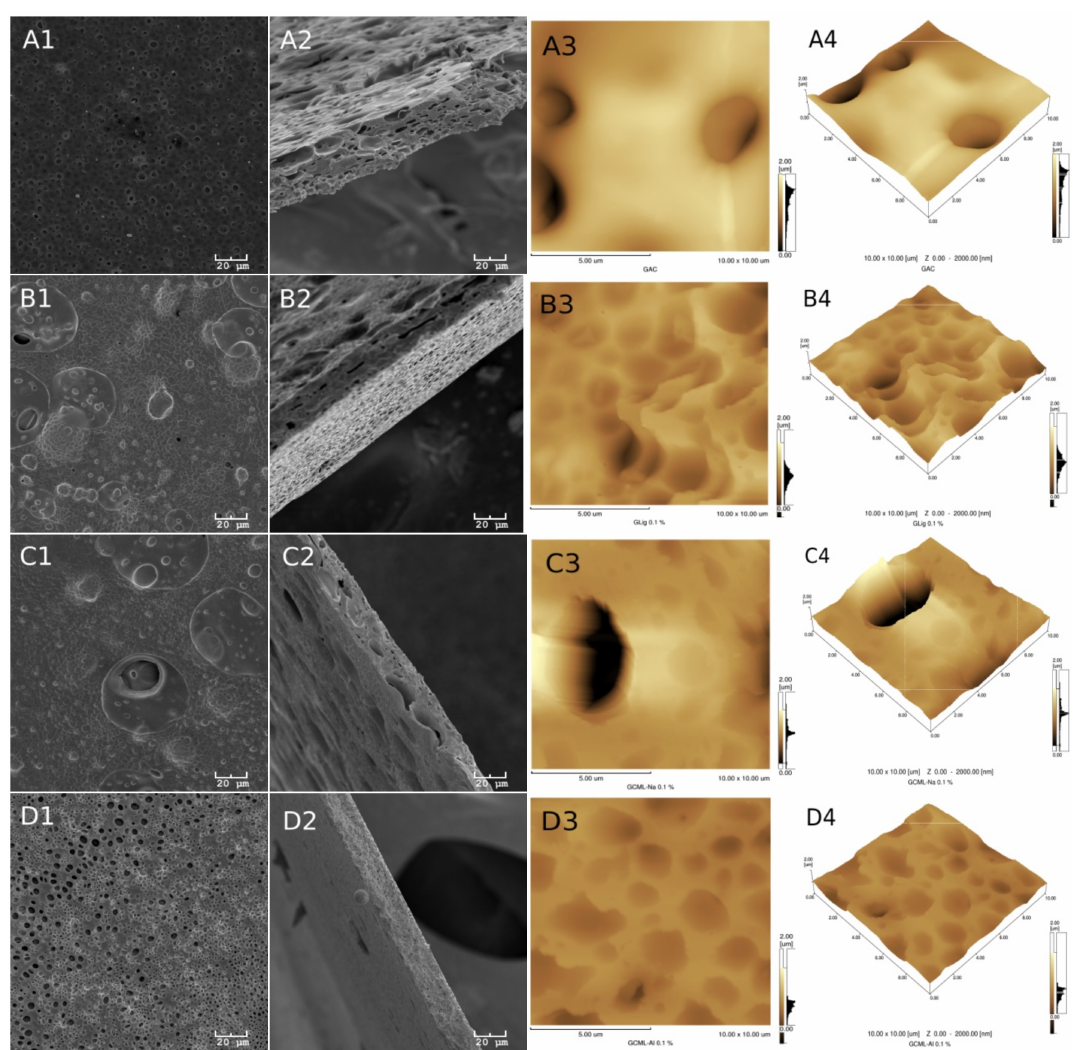
Figure 3. The letters A, B, C and D refer to the membranes of groups I and II described in Figure 1. Numbers 1, 2, 3 and 4, in A1 through D4, refer to surface SEMs (1) and fracture (2) of the membranes and the two-dimensional (3) and three-dimensional (4) AFM of the membranes of group II. A certain superficial homogeneity and low porosity for the samples of group I are observed in images 1 and 3. However, after incorporating glycerol (group II), a significant presence of pores can be observed in all of the images of Figure